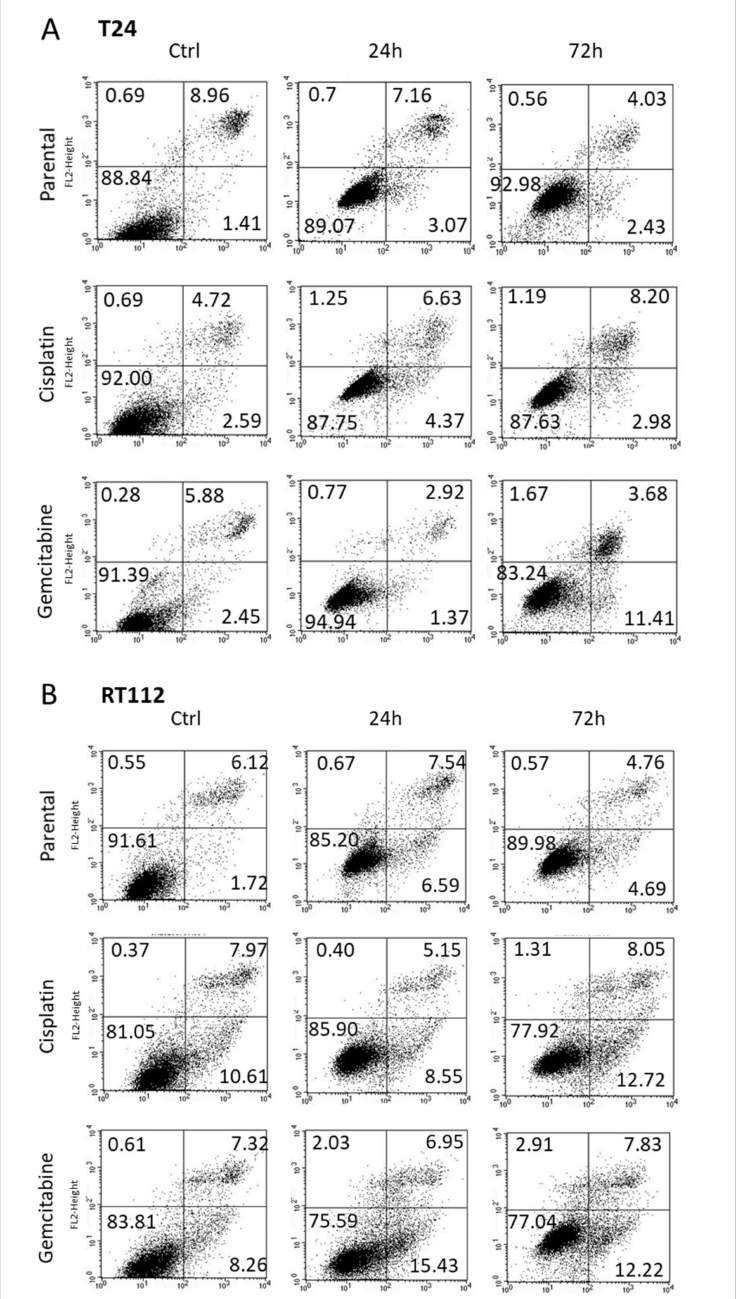
Figure 3. Early apoptosis, late apoptosis and necrosis of parental and resistant T24 ( A ) and RT112 ( B ) cells treated with OMWW 1:250 for 24 and 72 h. Controls remained untreated. Upper left quadrants to show the percentage of cells in necrosis, upper right quadrants percentage of cells in late apoptosis, lower right quadrants percentage of cells in early apoptosis, and lower left quadrants vital cells (one representative of 3 analyses; SDintra-assay <